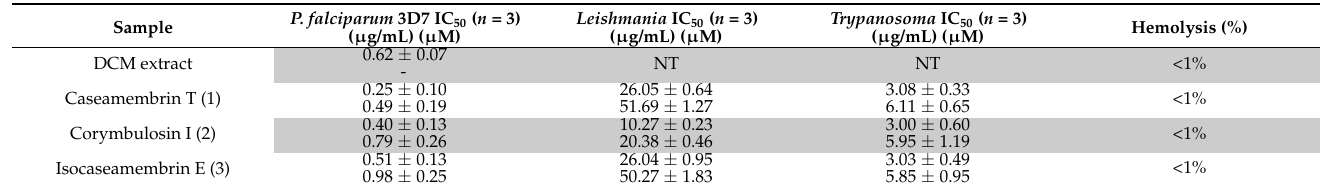
Table 2. IC 50 of compounds 1 – 3 and the crude extract on the investigated parasites, expressed in µ g/mL ± SD and in µ M ± SD). The activities against Trypanosoma and Plasmodium differ from the anti-leishmanial activity, and the activities of compounds 1 and 3 are closer than those of compound 2 . No product or extract caused hemolytic